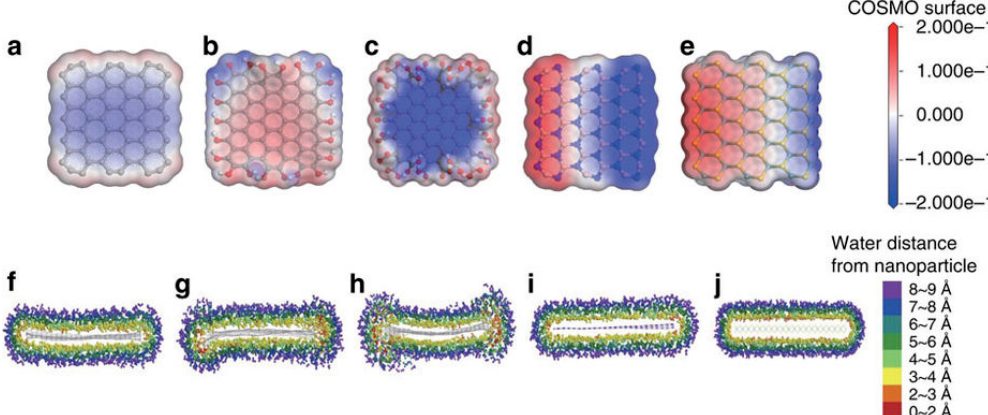
Figure 23. Molecular simulation results of solubility of 2D materials in water. Charge density of water around ( a ) pristine graphene, ( b ) –OH functionalized graphene, ( c ) –COOH functionalized graphene, ( d ) h-BN, and ( e ) MoS 2 . The isosurface is constructed from the COSMO-solvation model. The change of surface charge is much larger in polar nanoparticles. Water distributions around ( f ) pristine graphene, ( g ) –OH functionalized graphene, ( h ) –COOH functionalized graphene, ( i ) h-BN, and ( j ) MoS 2 . Reproduced from [115]. Copyright Nature Publishing Group, 2015.